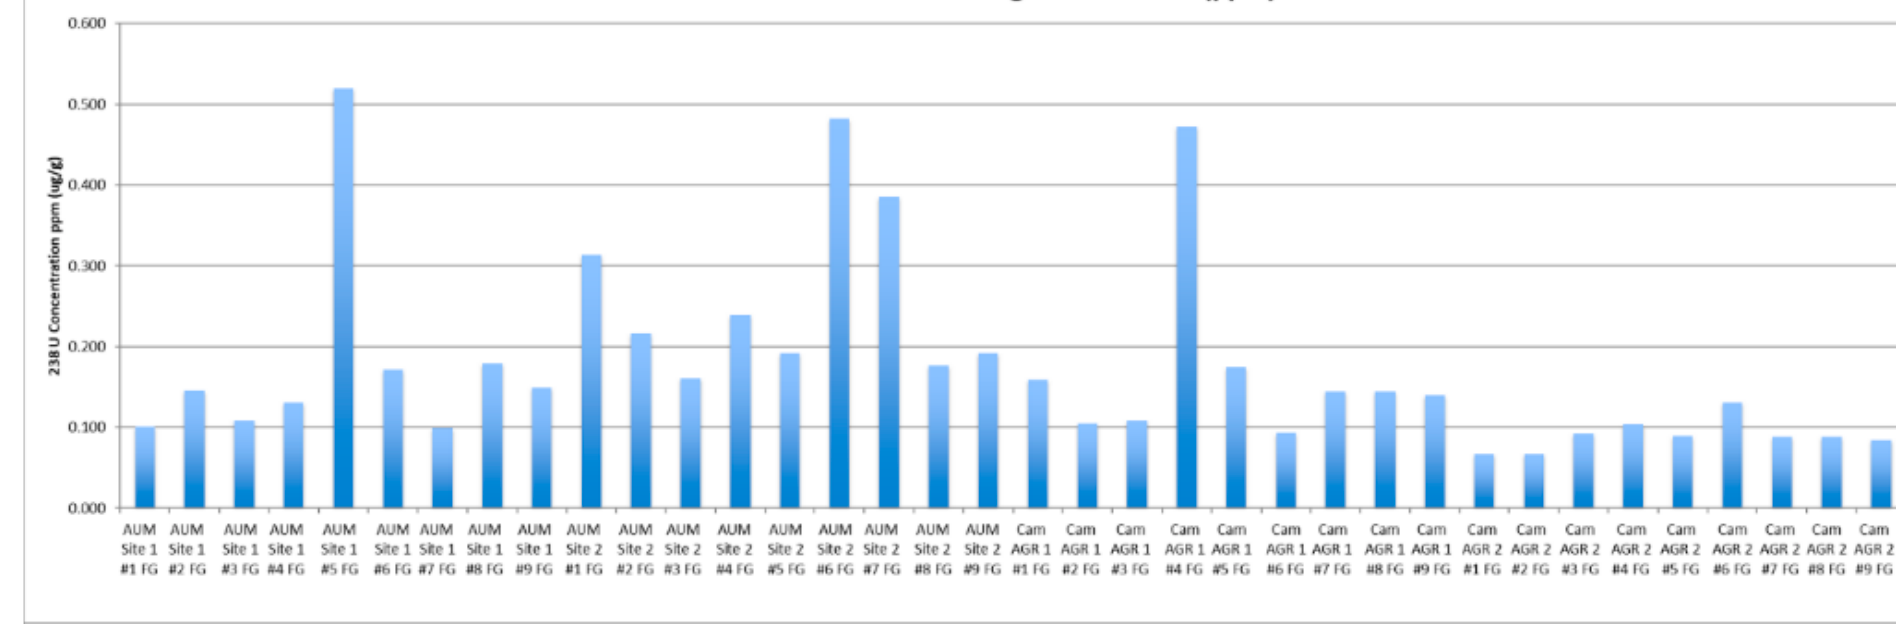
Figure 1. Uranium concentration in soil samples collected near proposed agricultural sites. Displayed are abandoned uranium mine (AUM) and agricultural sites (AGR).